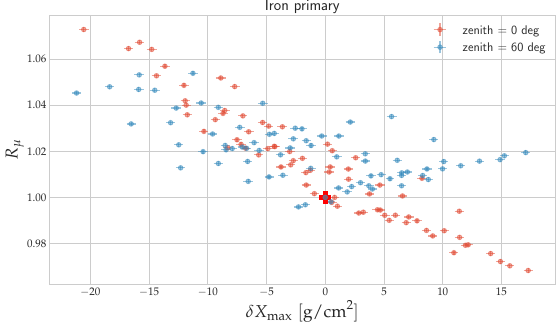
Figure 2. Results of simulations in [ δ X max , R µ ], iron